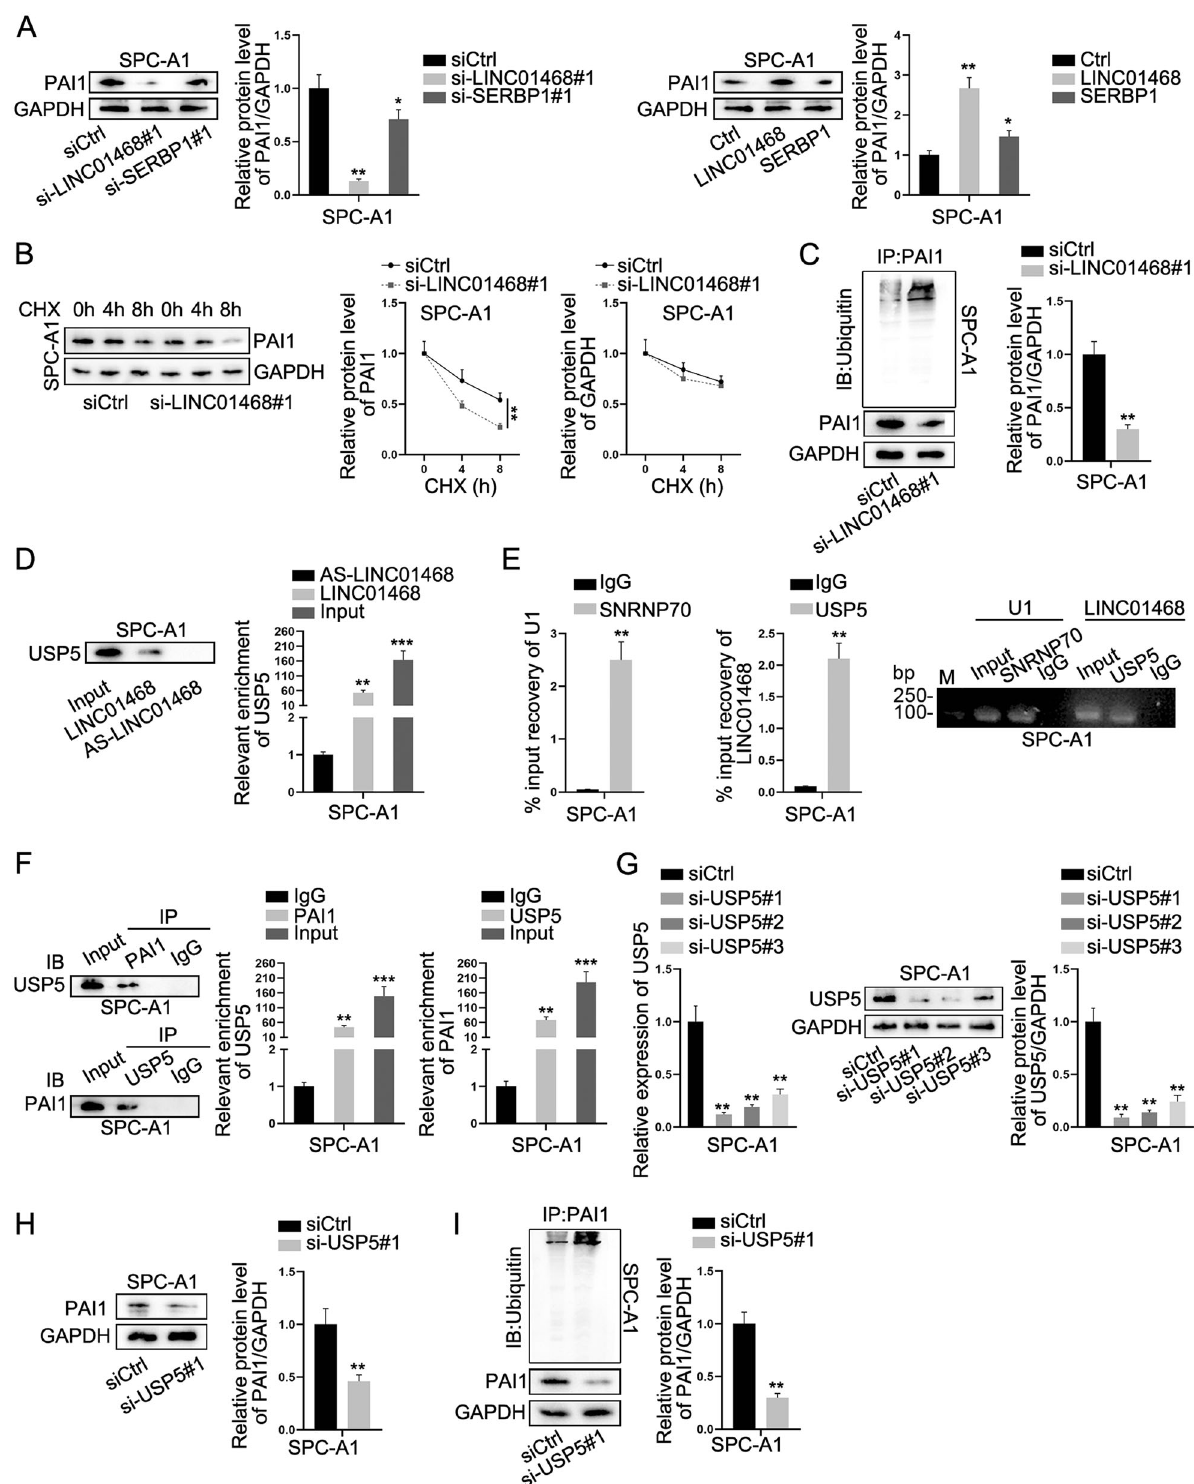
Fig. 6 LINC01468 impedes PAI1 protein degradation via interaction with USP5. A Protein levels of PAI1 in response to the knockdown or overexpression of LINC01468 or SERBP1 were measured via western blot. B After CHX treatment, western blot analysis was done to measure protein levels of PAI1 in cells with or without LINC01468 knockdown. C IP-WB was done for assessment of PAI1 ubiquitination under LINC01468 silence. D After RNA pull-down assay, western blot was done to detect USP5 level pulled down by indicated probes. E The binding correlation between LINC01468 and USP5 was veri fi ed via RIP assay. F Co-IP assay was applied for evaluation of the interaction between USP5 and PAI1. G The changes in USP5 mRNA and protein levels in cells transfected with si-USP5 were assessed via RT-qPCR and western blot. H The in fl uence of USP5 silence on PAI1 level was evaluated via western blot. I IP-WB was applied for assessment of PAI1 ubiquitination under the in fl uence of USP5 depletion. Results were exhibited as the mean ± SD on the basis of three independent experiments. * p < 0.05, ** p < 0.01 , *** p < 0.001 indicated the statistical signi fi cance of experiments data. Cell Death and Disease (2022)